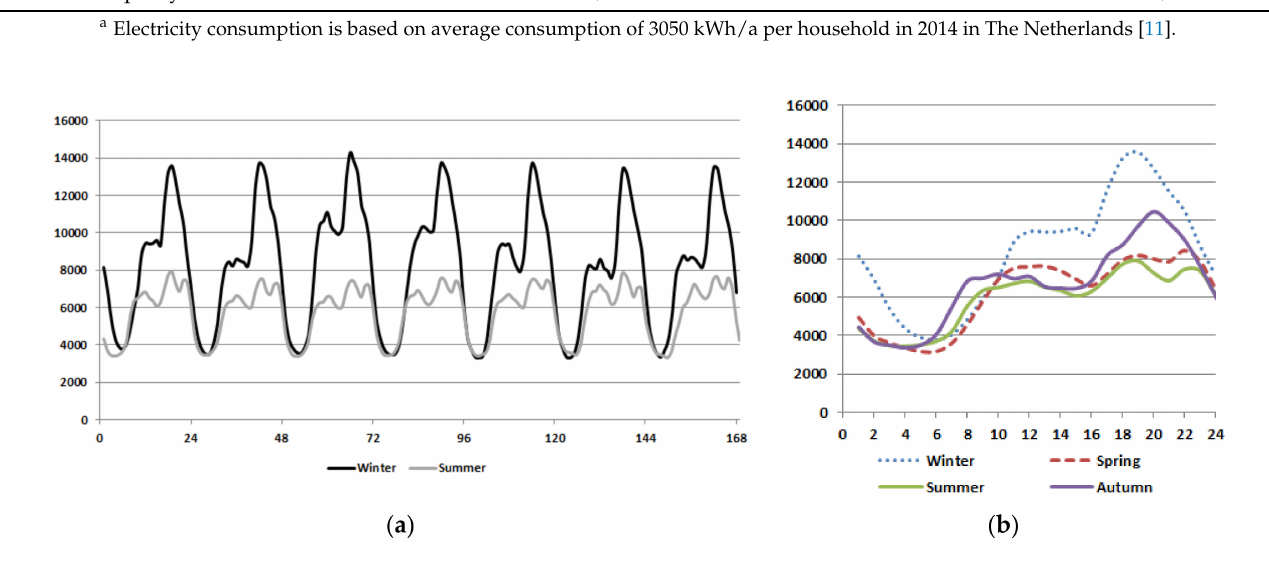
Figure A1. ( a ) Example of energy demand pattern for winter and summer week average municipality. ( b ) Example of energy demand pattern for winter, spring, summer, and autumn day average